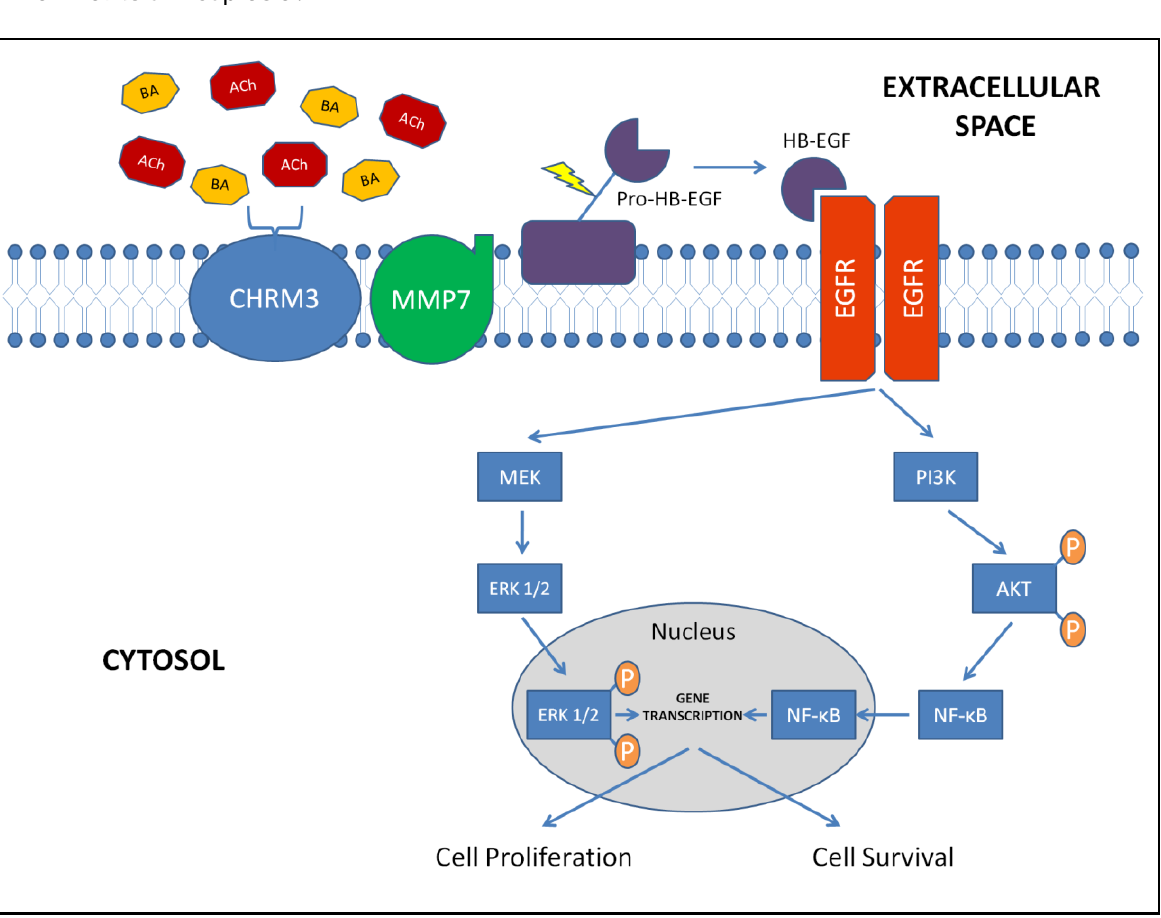
Figure 3. Muscarinic signaling in colonic epithelial cells. Acetylcholine (ACh)